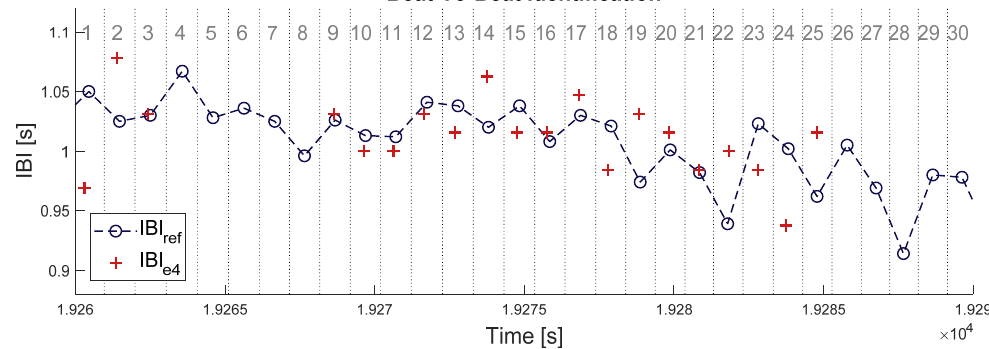
Figure 2. Illustration of beat-to-beat identification procedure in a 30 s time window. Blue circles with dashed line represent the IBI estimate from Zephyr BioHarness 3 (IBI bh ). Red crosses represent the IBI estimate from Empatica E4 (IBI e4 ). Vertical dotted lines delimit the time intervals attached to each IBI sample from BioHarness, which are numbered in grey at the top of the chart. Intervals N° 4, 5, 6, 7, 8, 26, 27, 28, 29, and 30 have no red crosses; thus, 10 samples (33%) are missing in signal IBI e4 . All red crosses here are matched samples, so that no sample is overdetected in signal IBI e4 .